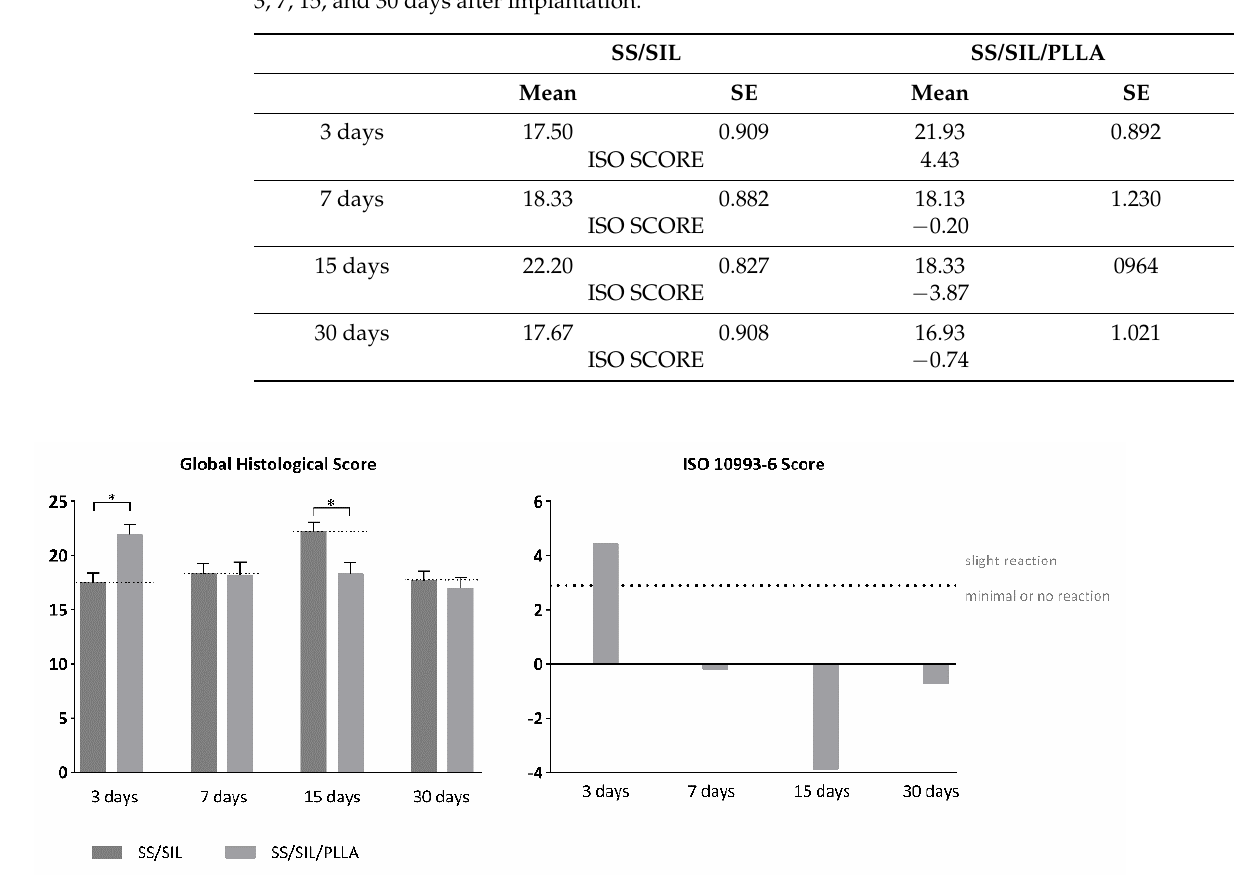
Figure 7. Global histological score (left panel) and calculated score, compared to the negative control (SS/SIL), according to ISO 10993-6:2016 (right panel), for subcutaneous implantation (biocompatibility assessment) of the devices, after 3, 7, 15, and 30 days post-implantation time. Results are presented in mean ± SEM. Differences were considered statistically significant at p < 0.05. Results significance are presented through the symbol (*), according to the p -value, with one, two, three or four symbols, corresponding to 0.01 ≤ p < 0.05; 0.001 ≤ p < 0.01; 0.0001 ≤ p < 0.001; and p < 0.0001, respectively.